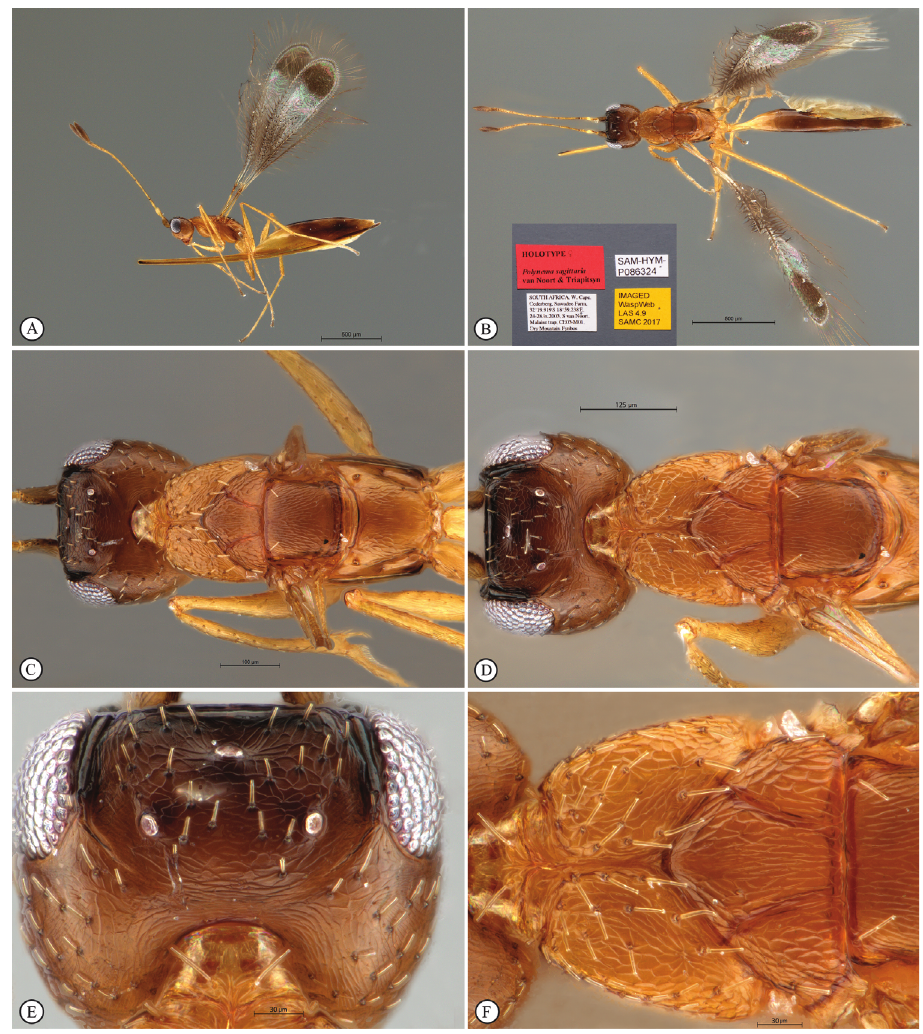
Figure 1. Polynema sagittaria Holotype female. A Habitus, lateral view B Habitus, dorsal view (inset: data labels) C Head and mesosoma, dorsal view D Head and mesosoma, anterior-dorsal view E Head, vertex F Pronotum and mesoscutum, dorsal